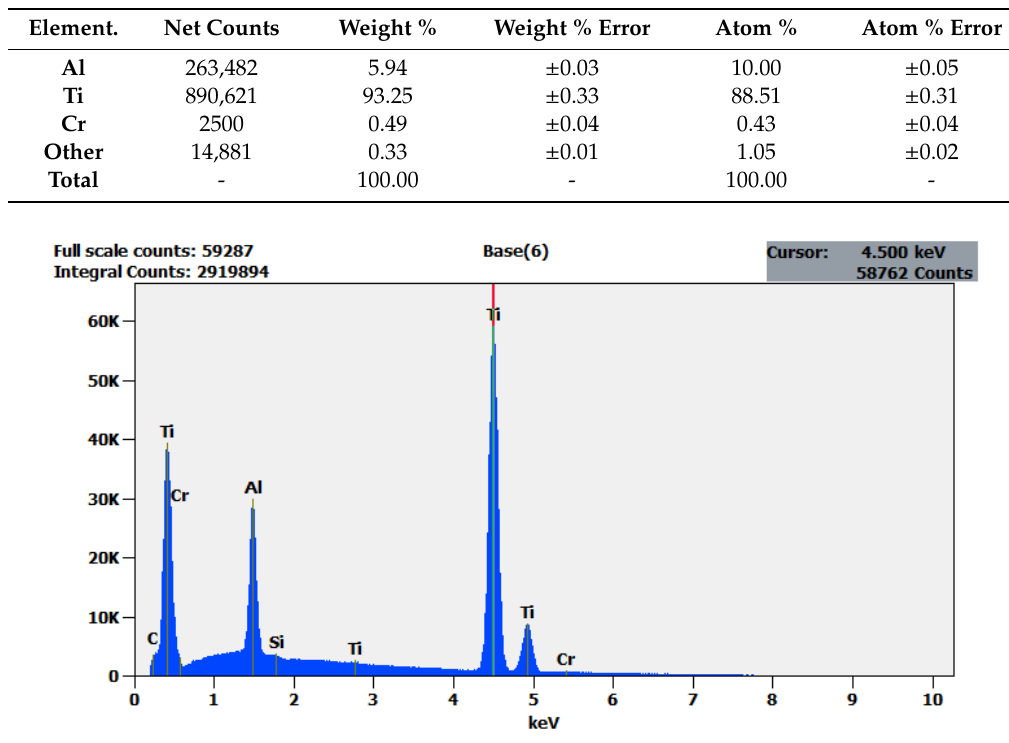
Figure 1. The measurements were carried out in a plane parallel to the length of the sample in the middle of it along its thickness. Table 1. Analysed chemical composition of test material. Table 1. Analysed chemical composition of test material.